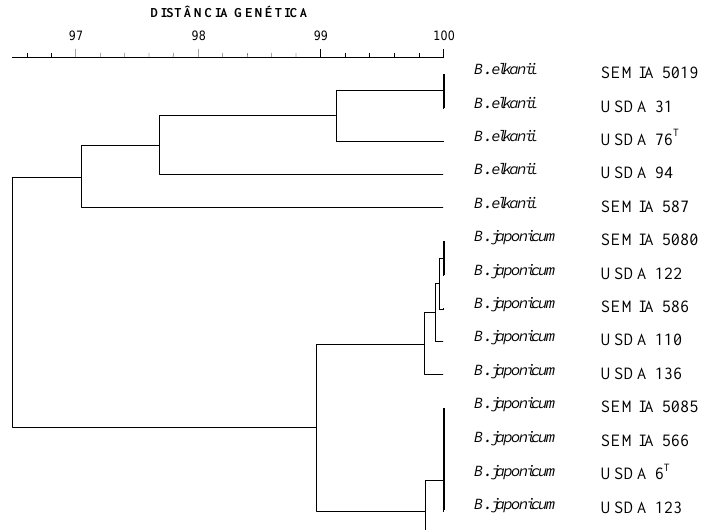
Figura 1. Dendrograma (UPGMA) mostrando as relações genéticas entre os genes 16S rRNA das estirpes SEMIA recomendadas comercialmente para a cultura da soja e das estirpes representativas das espécies B. japonicum e B. elkanii